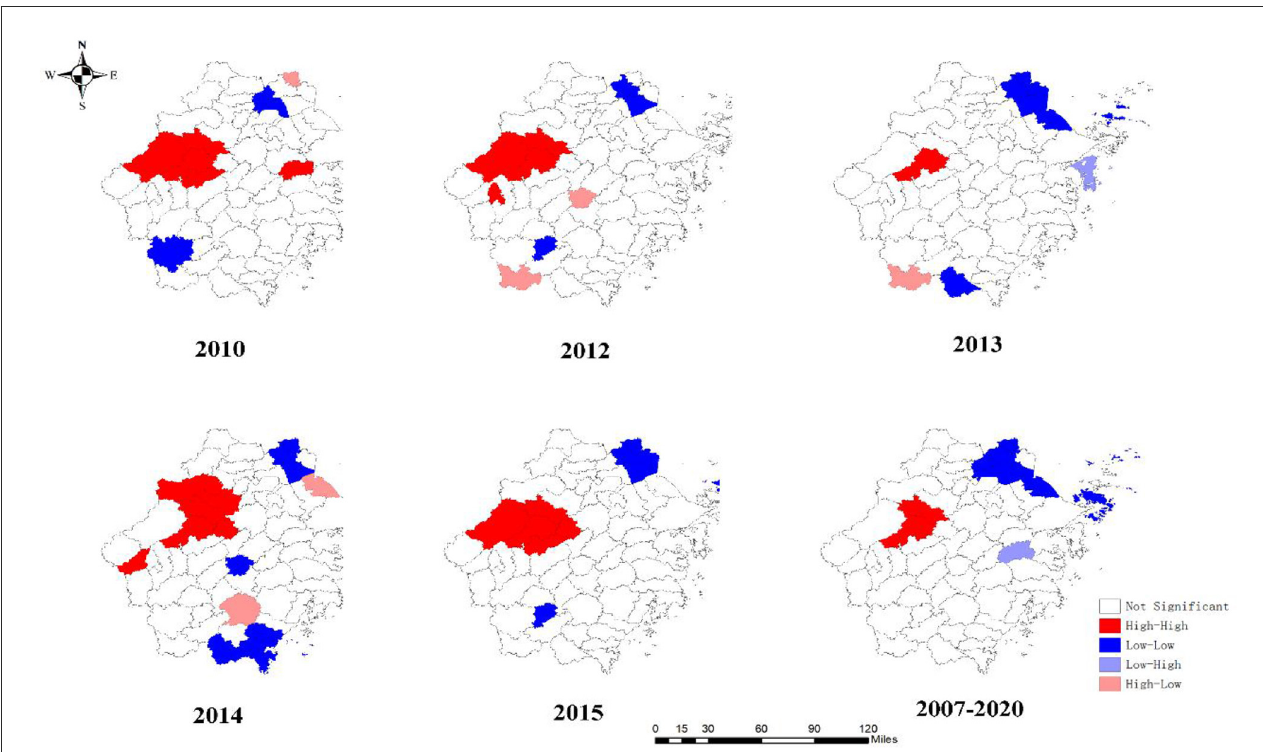
FIGURE4 Local spatial autocorrelation of notified PTB incidence among students in Zhejiang